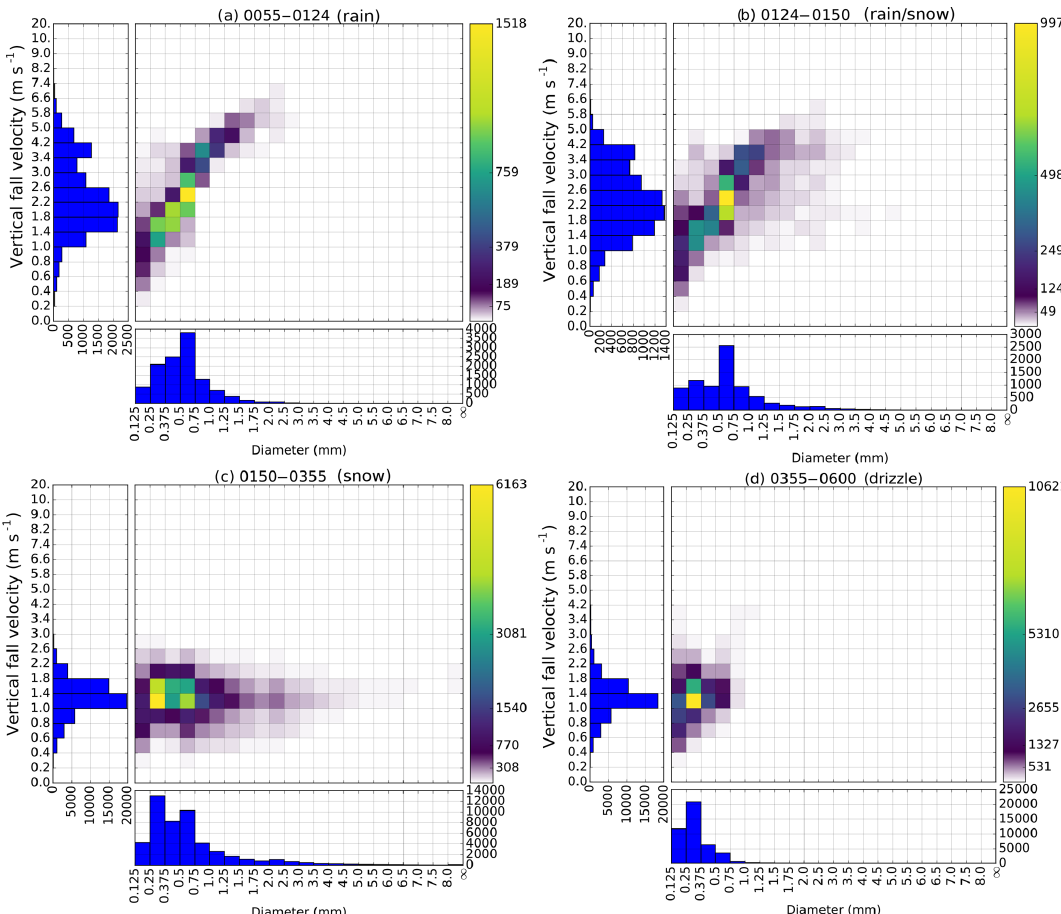
Figure 9. Accumulated particle information for each hydrometeor class period described in Fig. 8. The centre grid shows particle counts binned by size and fall velocity. The y -axis histogram shows particle velocity distribution (DVD) and the x -axis histogram shows particle size distribution (DSD) for the time period described. Since the time periods between each subplot are inconsistent in length, the colour scale and histograms have been normalized for the total precipitation over each period. The periods are as follows: (a) 00:55–01:24UTC (rain), (b) 01:24–01:50 (rain/snow), (c) 01:50–03:55 (snow), and (d) 03:55–06:00